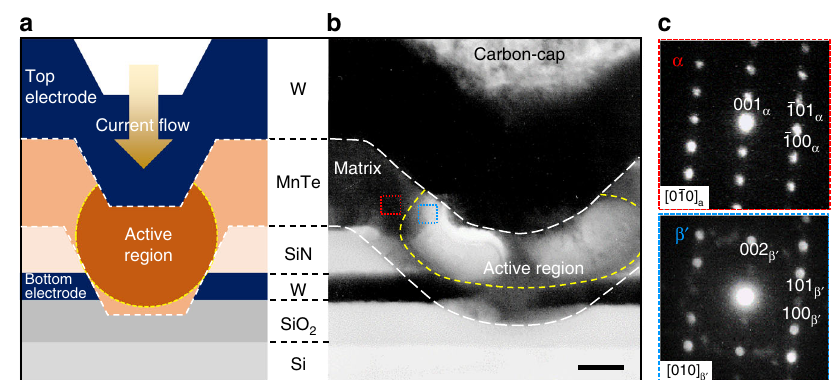
Fig. 2 Microstructure of the MnTe device after RESET operation. a Schematic of the cross-section of the MnTe device. b Cross-sectional transmission electron microscopy (TEM) image of a MnTe device. Scale bar: 100 nm. The MnTe device showed a resistance switching from low (5.6 × 10 3 Ω ) to high (1.4 × 10 5 Ω ) resistance state by RESET operation (2.9 V for 50 ns). The bright contrast area in the MnTe layer corresponds to the severely thermally affected active region that was preferentially milled during TEM sample preparation with focus ion beam. c Selected area diffraction patterns (SADPs) from the matrix enclosed by the red-dotted line (upper) and active region enclosed by the blue-dotted